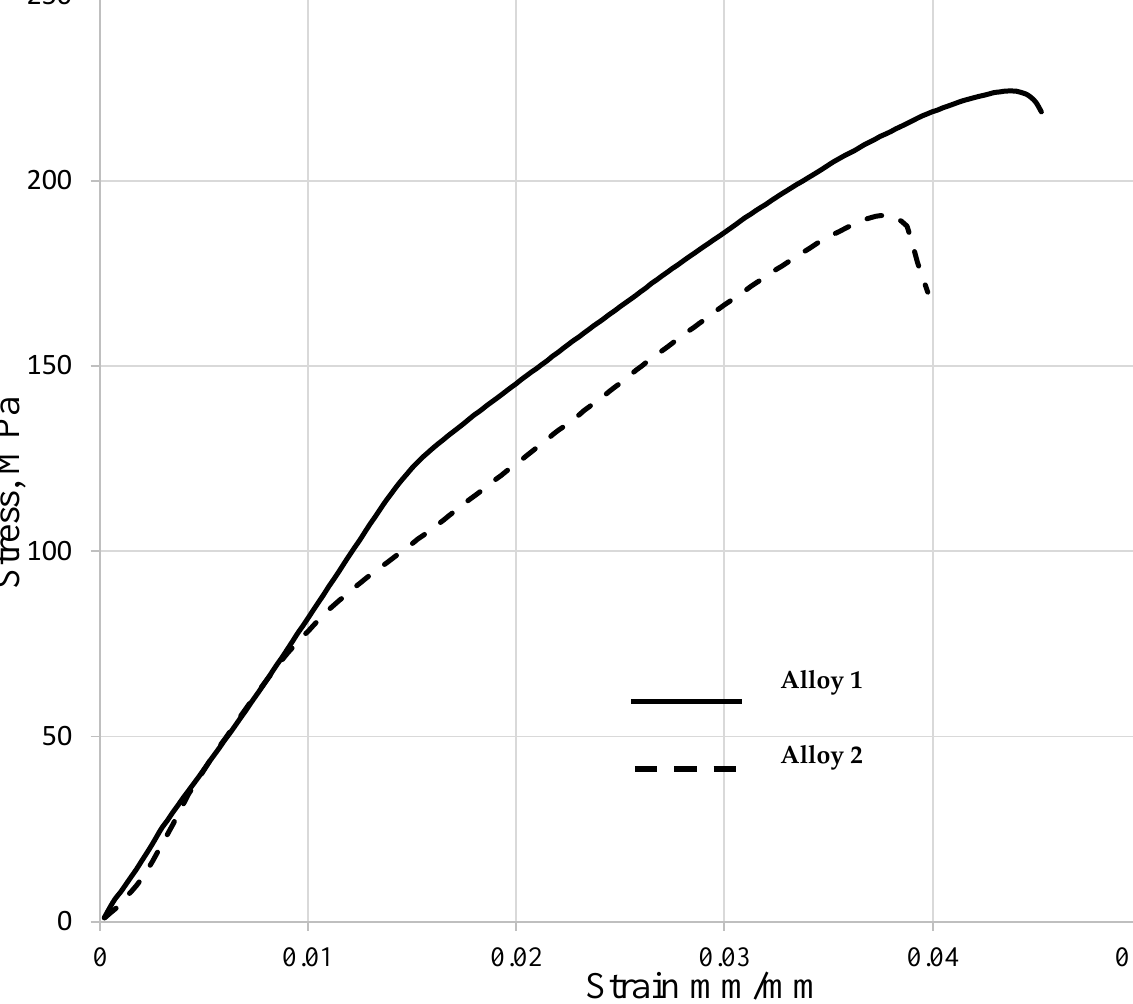
Figure 8. Engineering stress vs. strain curves of the peak-age-treated (PA) Al-Cu-Mg-Ag alloys at room temperature.